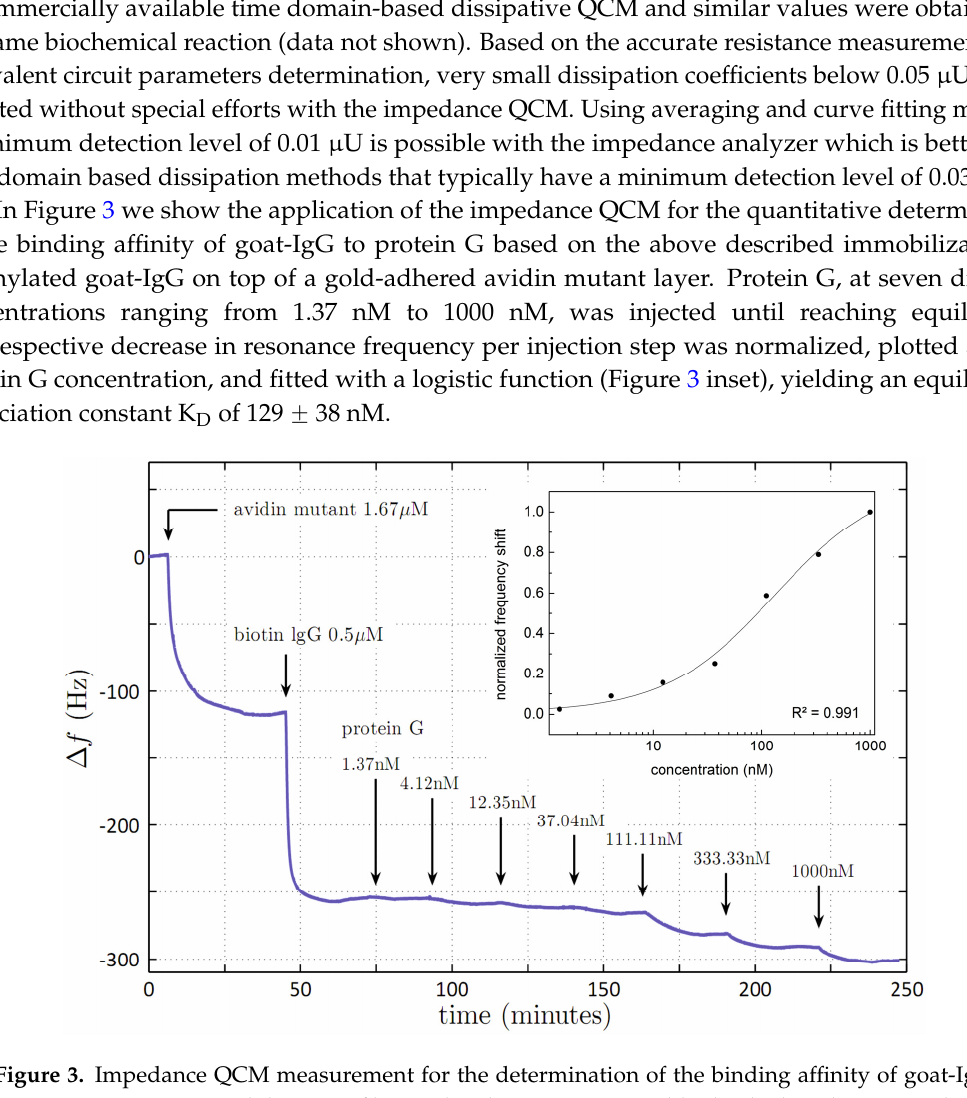
Figure 3. Impedance QCM measurement for the determination of the binding affinity of goat-IgG to protein G. Upon immobilization of biotinylated goat-IgG on a gold-adsorbed avidin-mutant layer, protein G was injected at different concentrations ranging from 1.37 nM to 1000 nM. For each step, the flow-cell was flushed with PBS after reaching equilibrium. Inset: Semi-logarithmic plot of normalized frequency shift per injection versus protein G-concentration, fitted with a logistic